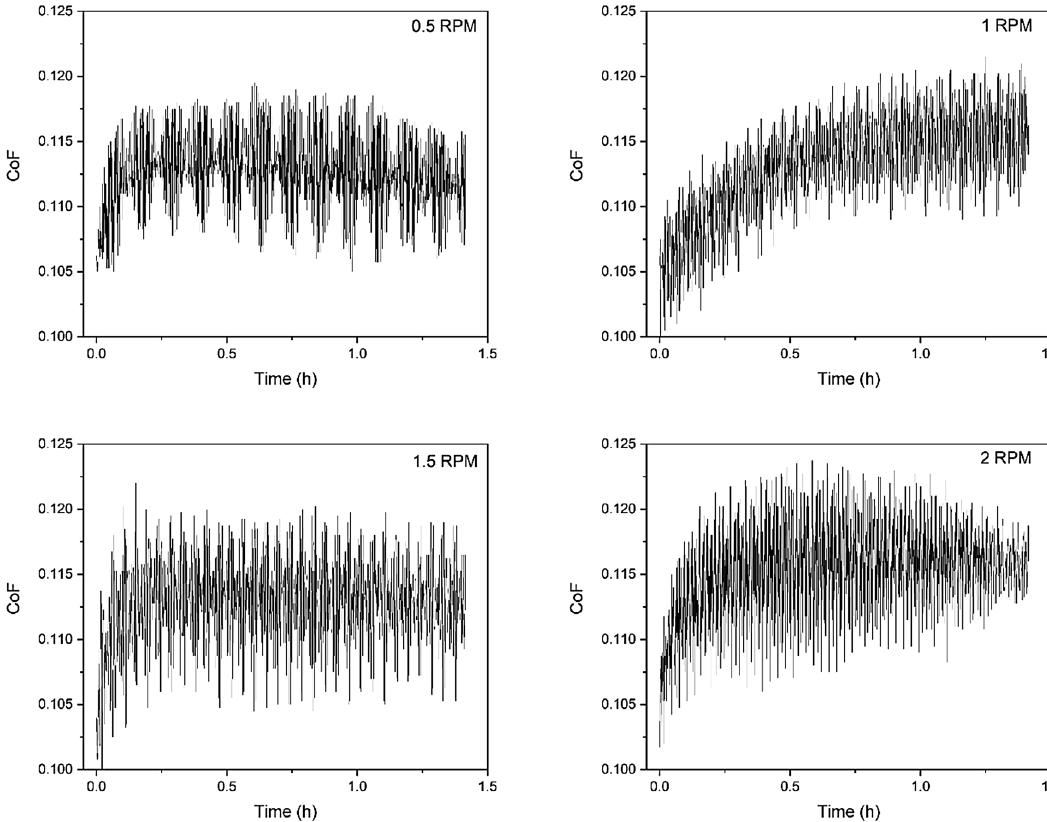
Figure 13. CoF evolution during wear tests for the multilayer coatings produced using different carousel rotation speeds. Carousel rotational speed (rpm)/periodicity (nm) Property